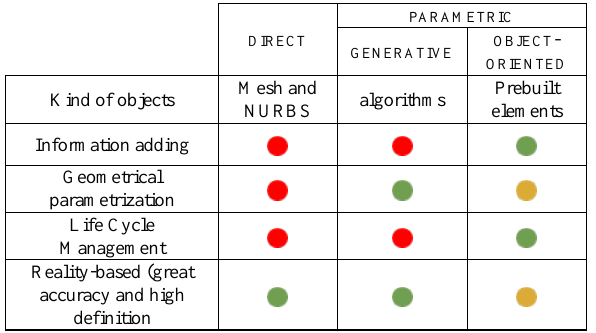
Table 1. Confronting the features of the modelling techniques